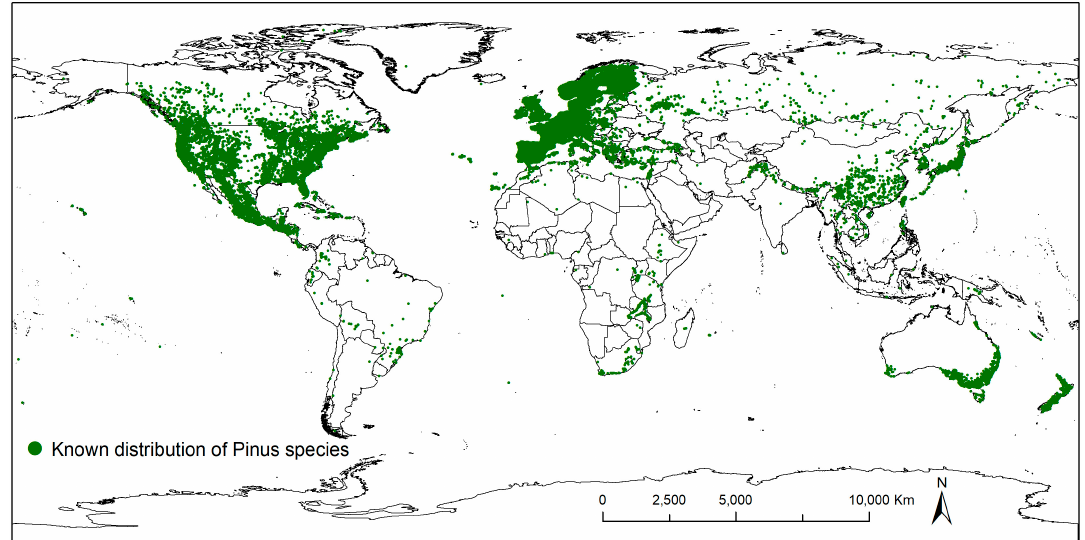
Figure 1. The known distribution of Pinus spp. based on published records. Green dots represent the known distribution records from the Global Biodiversity Information Facility (GBIF) database.